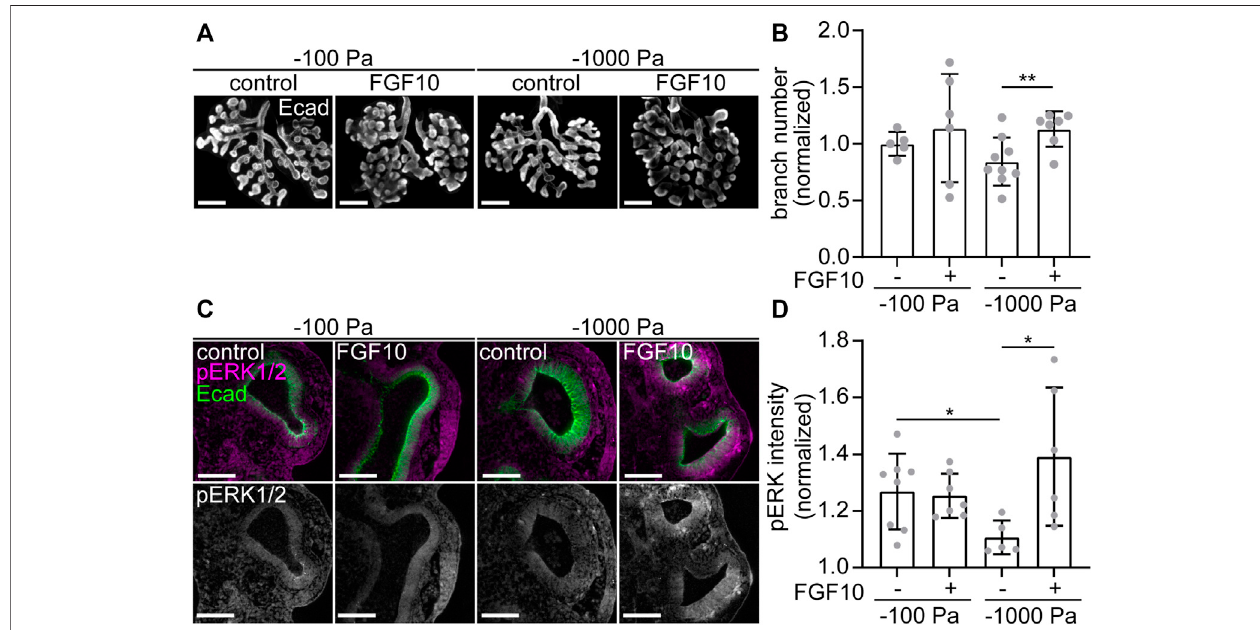
FIGURE 7 | Treatment with FGF10 rescues branching of explants held under high negative transpulmonary pressure. (A) E 12.5 lungs cultured under negative transpulmonary pressure with or without exogenous FGF10 for 24 h and then immunostained for E-cadherin (Ecad). Scale bars represent 250 μ m. (B) Fold change of terminal branch number relative to controls (no FGF10, − 100 Pa) in explants after 24 h of culture under different negative transpulmonary pressures, in the presence or absence of exogenous FGF10. N (cid:1) 3 experimental replicates. Group compared by Student ’ s t -test. ** indicates p < 0.01. (C) E 12.5 lungs cultured under negative transpulmonary pressure with or without exogenous FGF10 for 24 h and then immunostained for Ecad and phosphorylated ERK1/2 (pERK). Scale bars represent 50 μ m. (D) pERKintensitynormalizedtobackgroundintensityinepithelialtipsfromlungsculturedat − 100 Paor − 1,000 PawithorwithoutFGF10for24 h( n (cid:1) 5 – 8,from 3 replicates). Groups were compared by t -test. * indicates p <